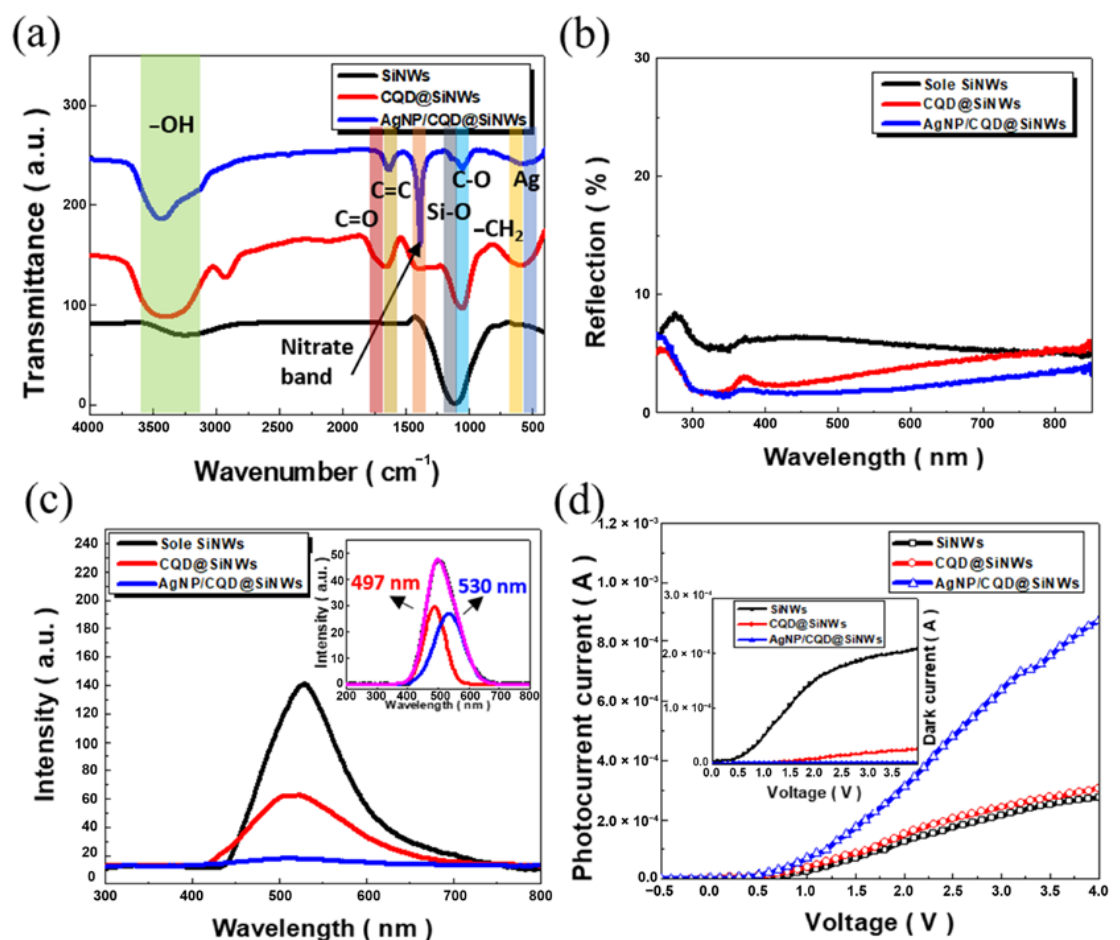
Figure 3. ( a ) FTIR, ( b ) light-reflectivity and ( c ) PL spctra of three various samples. ( d ) Measured results of photocurrent and Fig 3 dark current (inset of Figure 3d) of three various